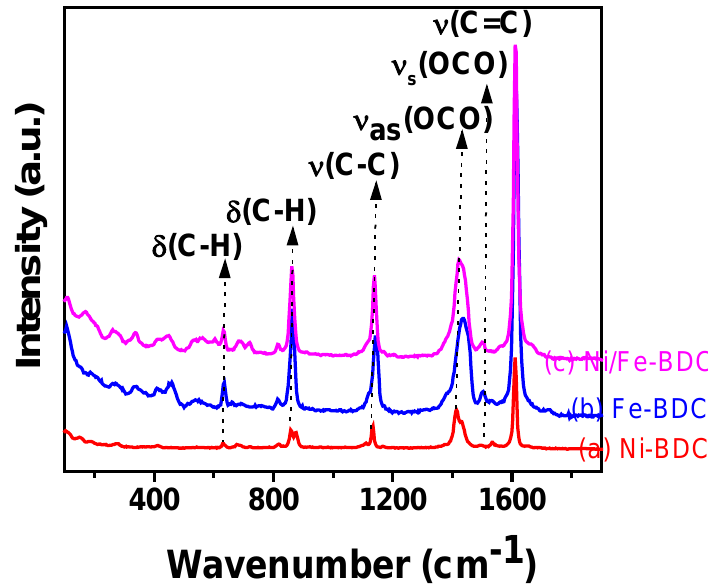
Figure 1. Raman spectroscopy of the Ni-1,4-Benzenedicarboxylic (Ni-BDC) ( a ), Fe-1,4-Benzenedicarboxylic (Fe-BDC) ( b ), and Fe 2 Ni-1,4-Benzenedicarboxylic (Fe 2 Ni-BDC) ( c ).